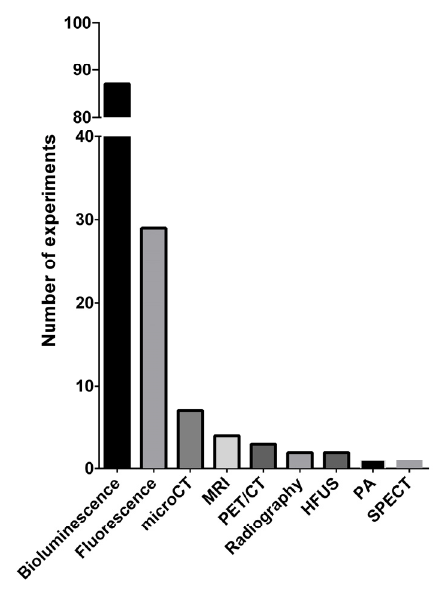
Figure 6. The absolute number of experiments for each imaging modality used to analyze the biodistribution and therapeutic effects of miRNAs’ delivery in mice. CT: computed tomography; MRI: magnetic resonance imaging; PET: positron emission tomography; HFUS: high-frequency ultrasonography; PA: photoacoustic; and SPECT: single-photon emission computed tomography. Bioluminescence was determined to be the most frequently used tool (64%); this tech-